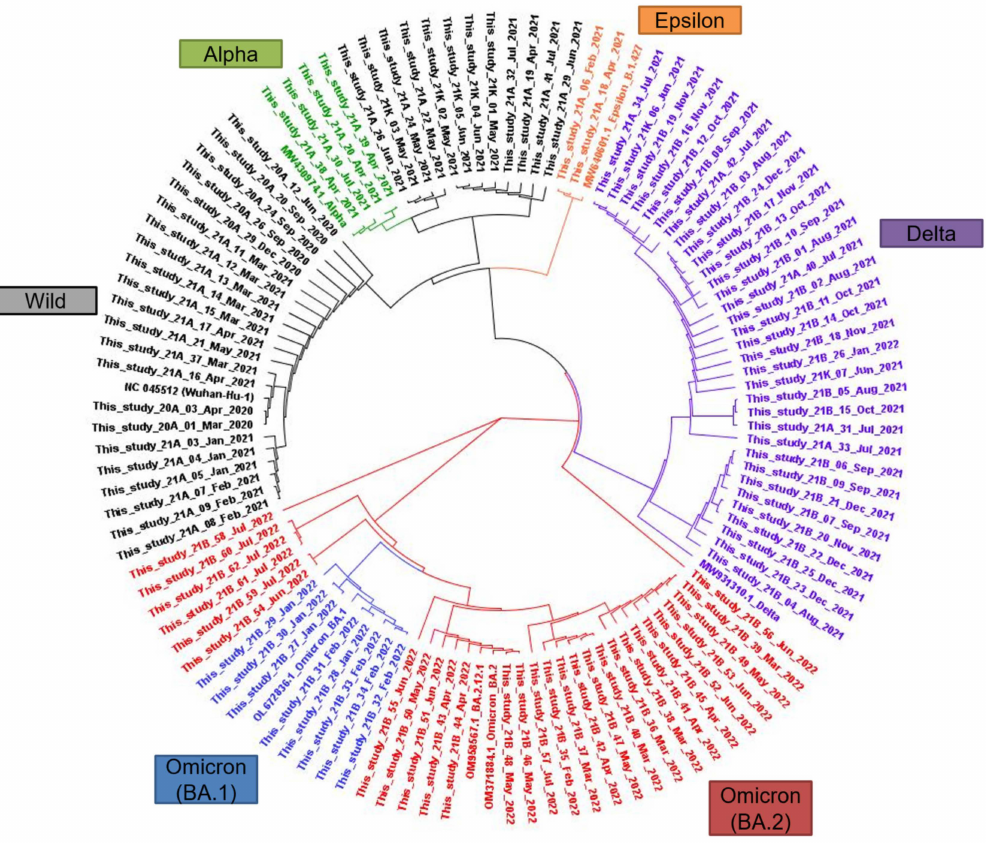
Figure 4. Circular phylogenetic tree representing the relationship of sequenced SARS-CoV-2 strains in South Korea between January 2020 and July